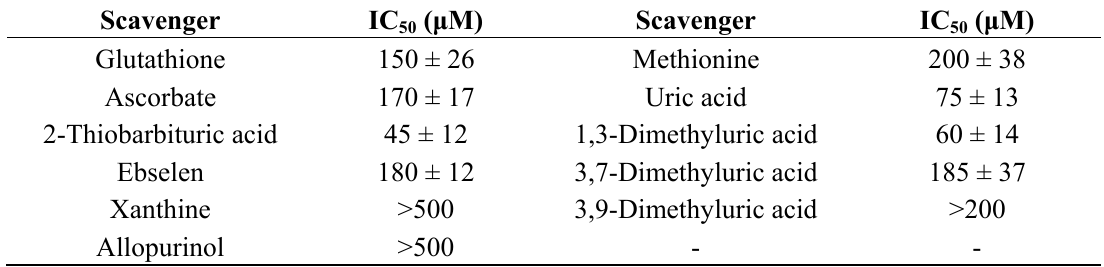
Table 2. Half-maximal inhibition concentrations (IC the nitration of bovine serum albumin (15 μ M) by peroxynitrite (1 mM) at pH